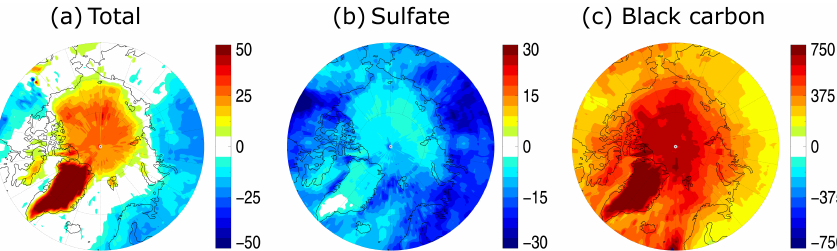
Figure 14. JJA mean model-median normalized DAE, i.e. total DAE (in Wm − 2 ) per total AOD (a) , sulfate DAE per sulfate AOD (b) , and BC FF DAE per BC AOD (c) . Note the different